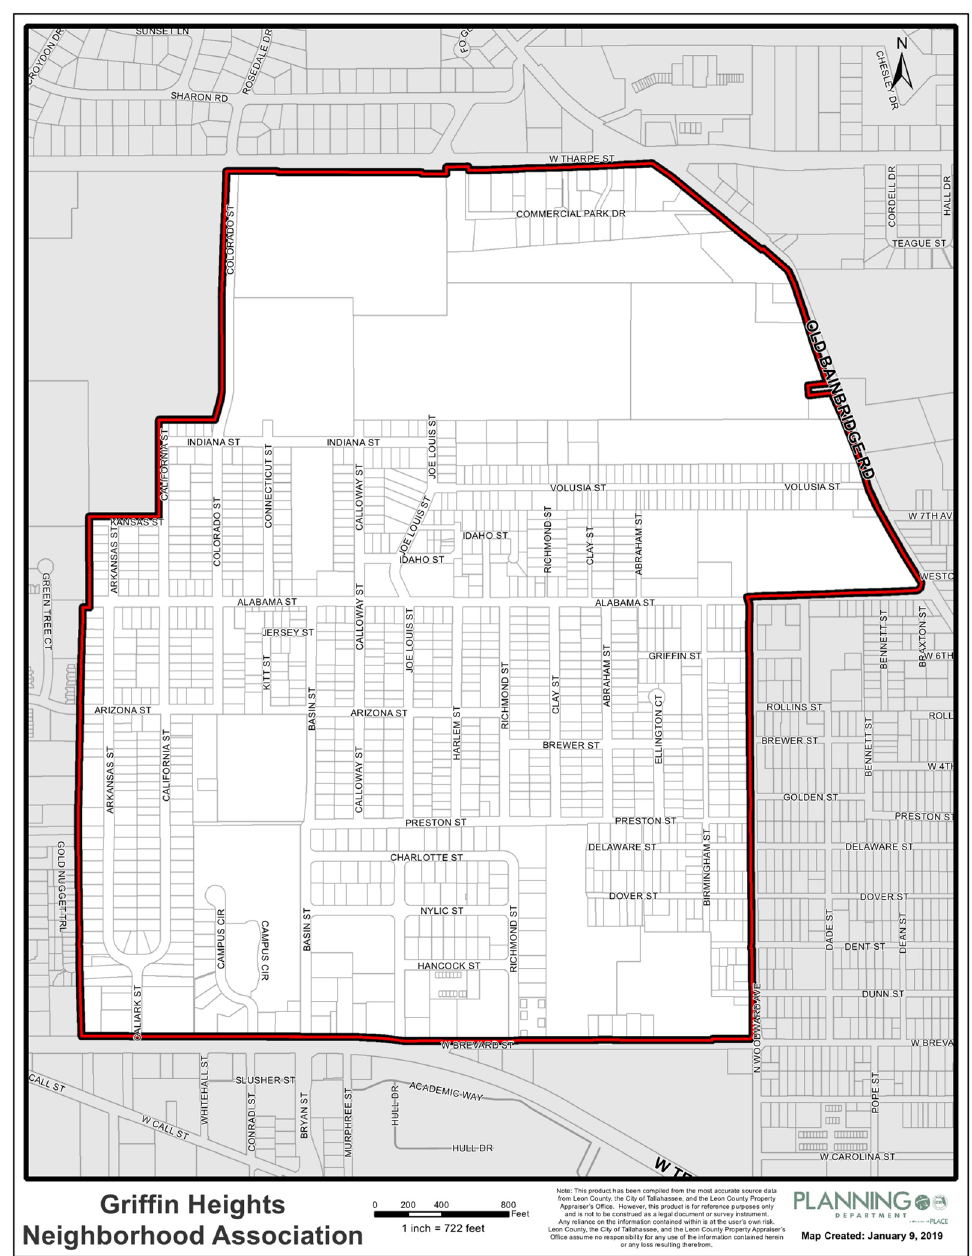
Figure 4. Gri ffi n Heights Neighborhood Boundaries (Source: City of Figure 4. Griffin Heights Neighborhood Boundaries (Source: City of Tallahassee).